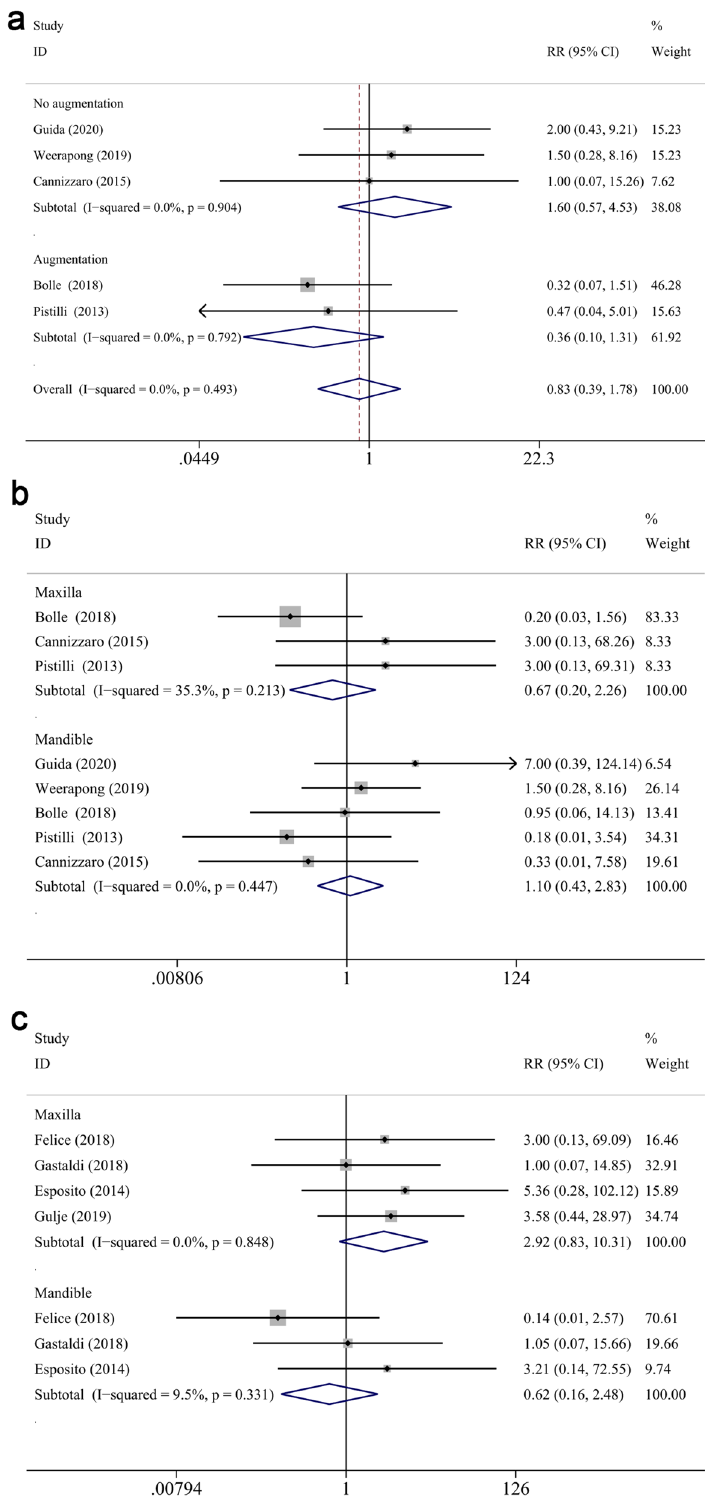
Figure 12. Subgroup analyses for the effects of augmentation on prosthesis complication rate at 1-year ( a ). Subgroup analyses of maxilla/mandible on prosthesis complication rate at 1-year ( b ) and 3-years ( c ) follow-up. Mantel–Haenszel (MH)-weighted RR < 1 indicated a lower complication rate of extra-short implants than the longer